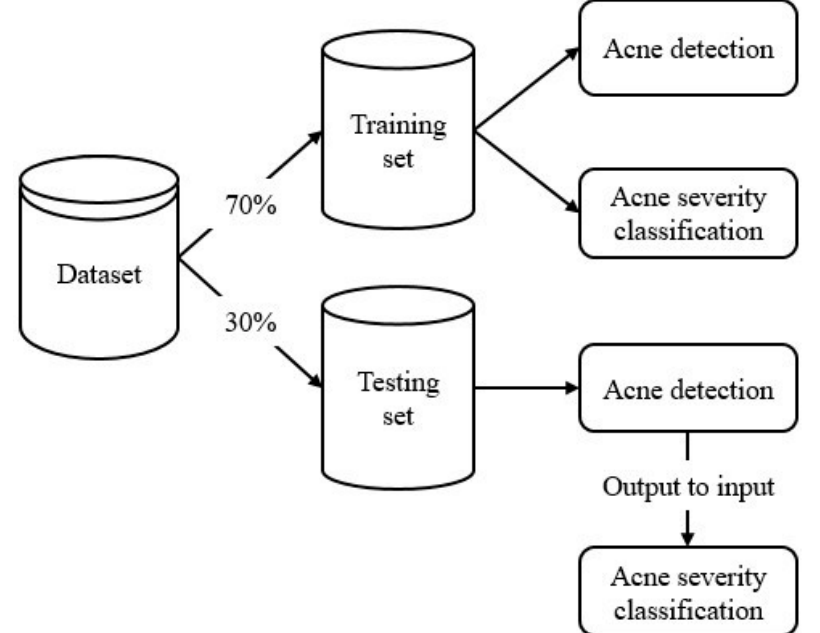
Figure 3. Data were divided into a ratio of 70:30 for training and testing.